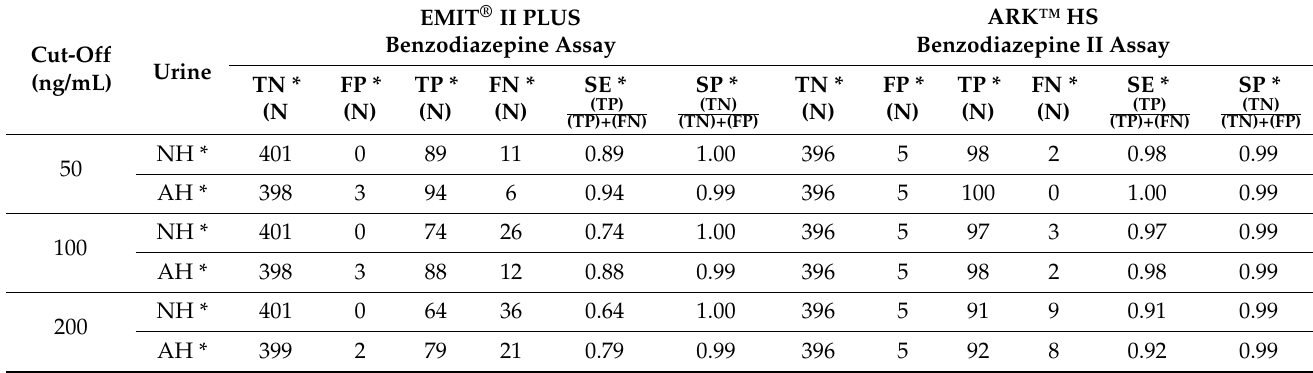
Table 2. Diagnostic sensitivity and specificity of the two immunoassays (LC-MS/MS data used as gold